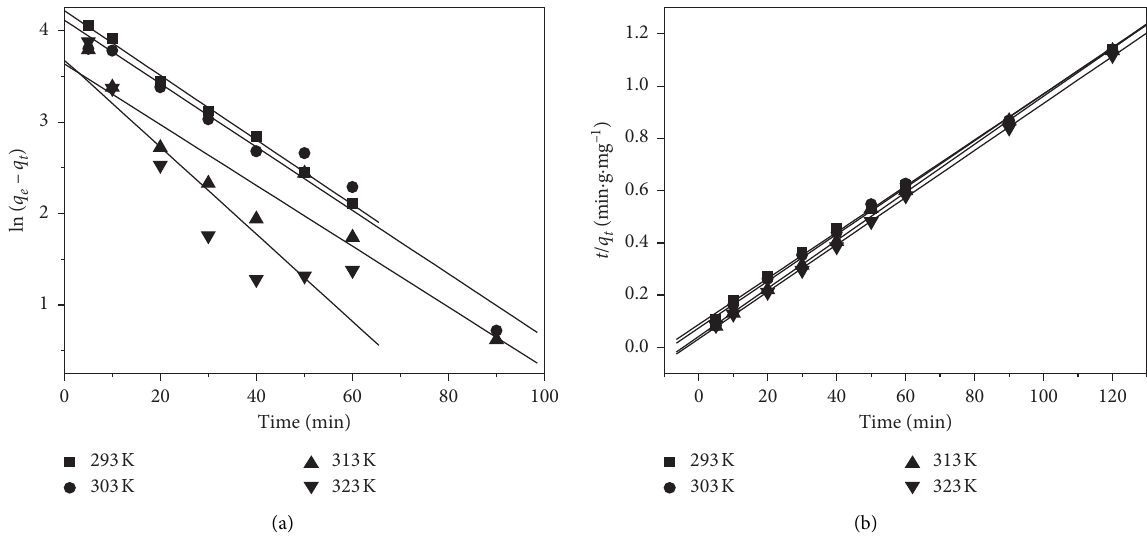
Figure 9: (a) The pseudo -first-order kinetic model and (b) pseudo -second-order kinetic model of phenol red adsorption by AlCB at different temperatures ( C o (phenol red) � 100mg L − 1 , pH 3.0, m � 0.2g).